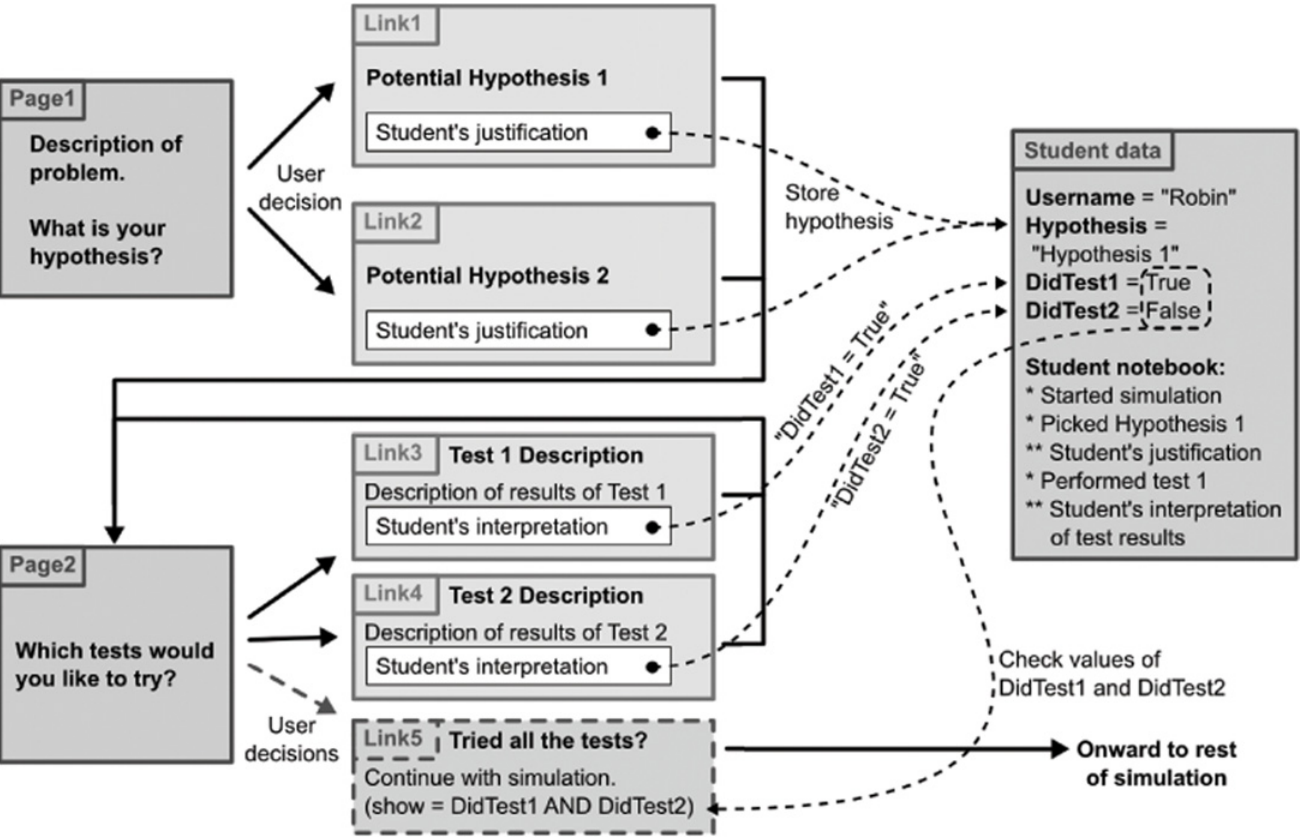
Fig 1. Schematic of SCI simulation architecture. After logging into the appropriate simulation, students read pertinent background information and are introduced to problem (i.e. unexplainable deaths of a certain animal species) and generate a hypothesis to explain the cause. Students are then asked to pick a hypothesis from a list of pre-generated hypotheses ( Seizing Sea Lions and Neural Tube Defects ) or to come up with their own hypothesis ( Unusual Mortality Events ) and then asked to give their rationale for their hypothesis. Students are then taken to the tests section of the simulation where they are given the option to try a variety of tests, in any manner of their choosing. After the student has completed a previously determined number of tests, a link appears (shown as Link 5 in the diagram) which allows the student to move forward in the